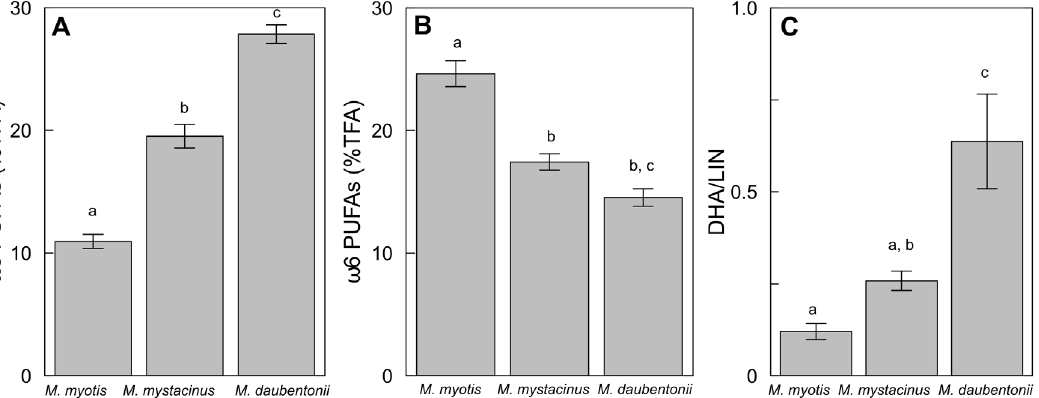
Figure 4. A. v 3 PUFAs, B. v 6 PUFAs and C. DHA/LIN ratio per species. Mean values 6 standard errors of A. v 3 PUFAs, B. v 6 PUFAs and C. DHA/LIN ratio from the faeces of Myotis myotis (n=29), M. mystacinus (n=24) and M. daubentonii (n=18). %TFA= % of total fatty acid. The groups with different letter were different. doi:10.1371/journal.pone.0083452.g004 PLOS ONE |